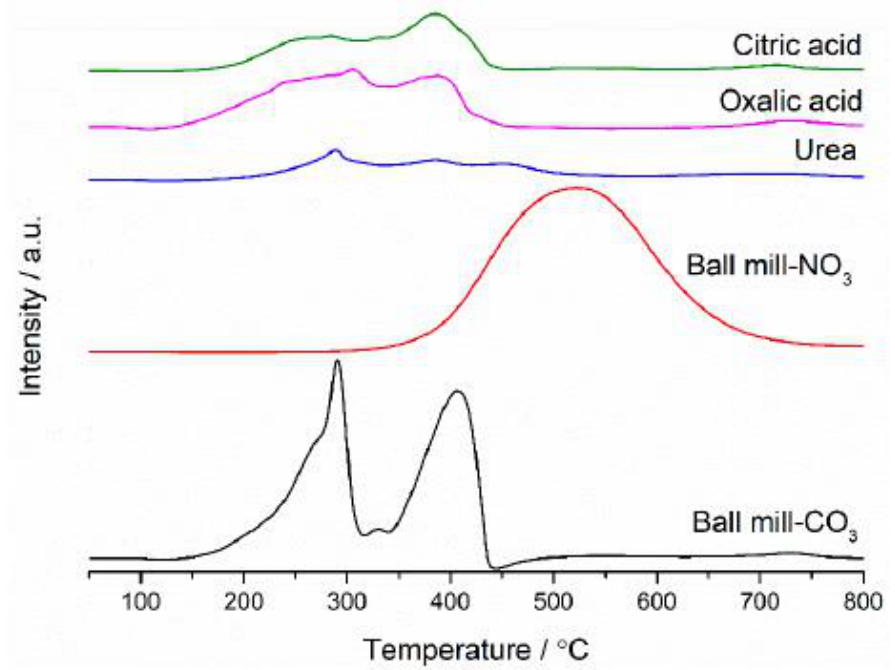
Figure 10. TPR profiles of Ce 0.25 Mn 0.75 O x sample. Reaction conditions: 10% H 2 /Ar 30 mL min −1 , Temperature range 50 – 80 0 °C.